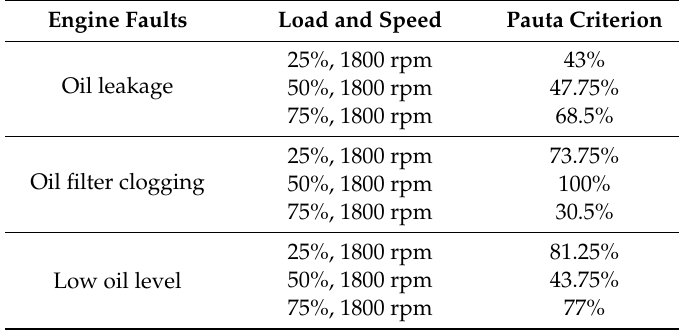
Table 4. The fault detection rate of three engine faults when using the Pauta